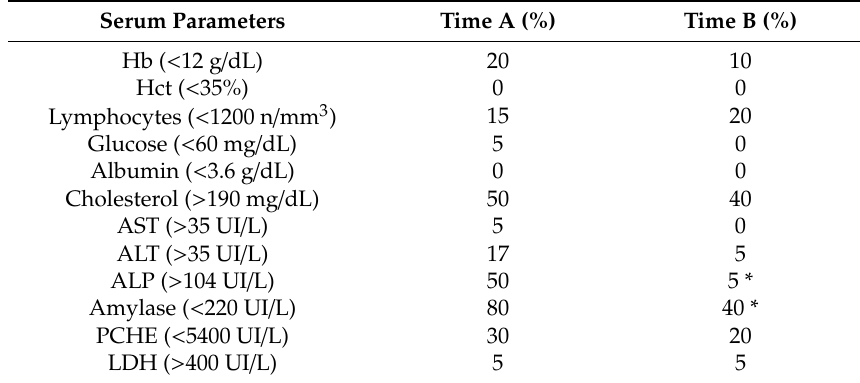
Data were analyzed by the chi-square test and are expressed as percentages; * p < 0.05. Hb, hemoglobin; Hct, hematocrit; AST, aspartate transaminase; ALP, phosphatase alkaline; PCHE, cholinesterase; LDH, lactate